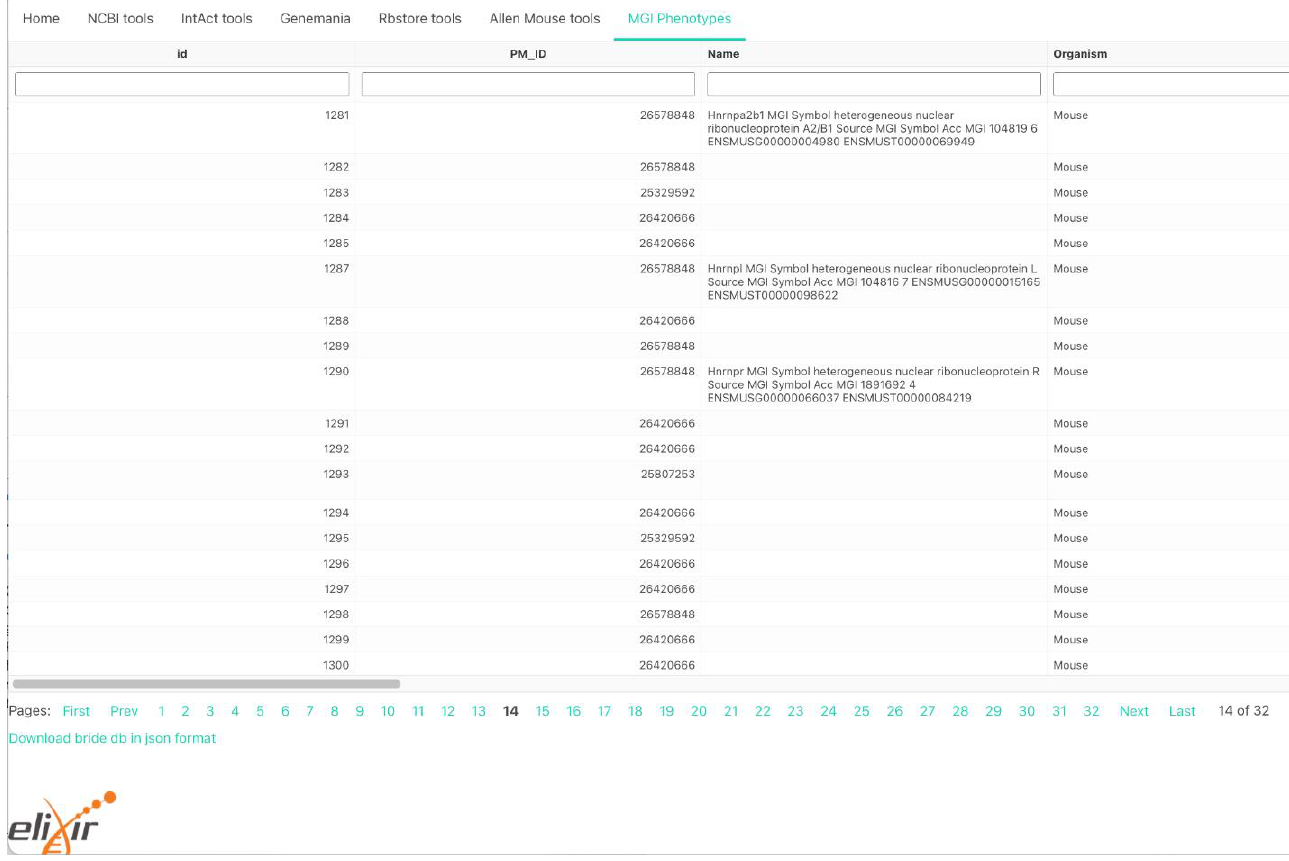
Figure 3. Views for the front-end of BRIDE v2.